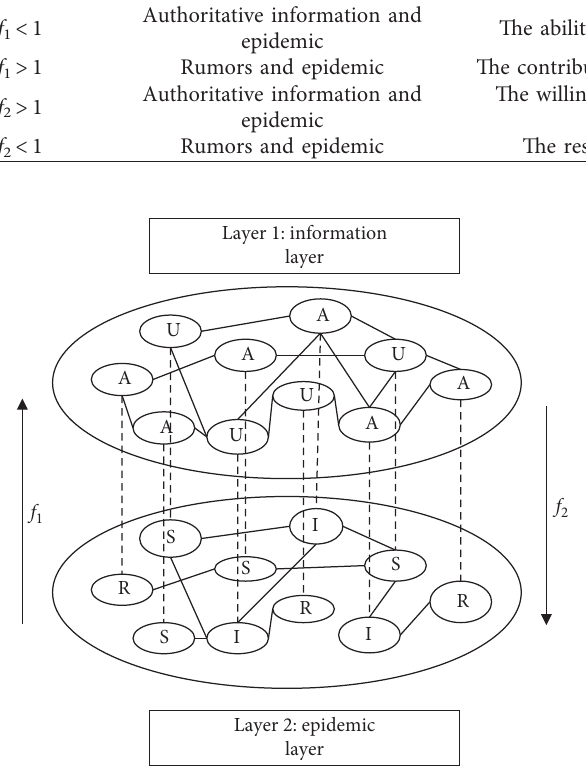
Figure 1: UAU-SIR model. Awareness is disseminating in layer 1, and the nodes have two possible states: unaware (U) or aware (A). Epidemic is spreading in layer 2, where the nodes have three possible states: susceptible (S), infected (I), and recovered